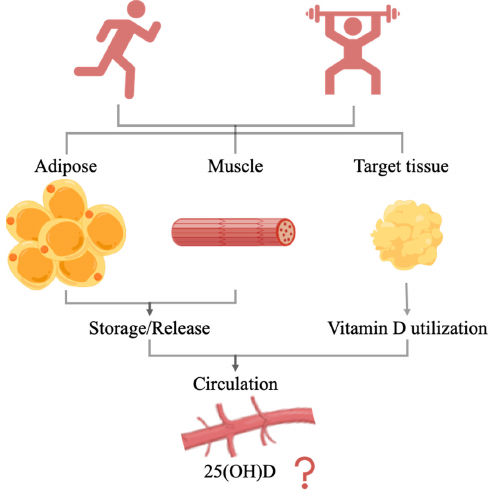
Figure 3. The effect of exercise on 25(OH)D in circulation.